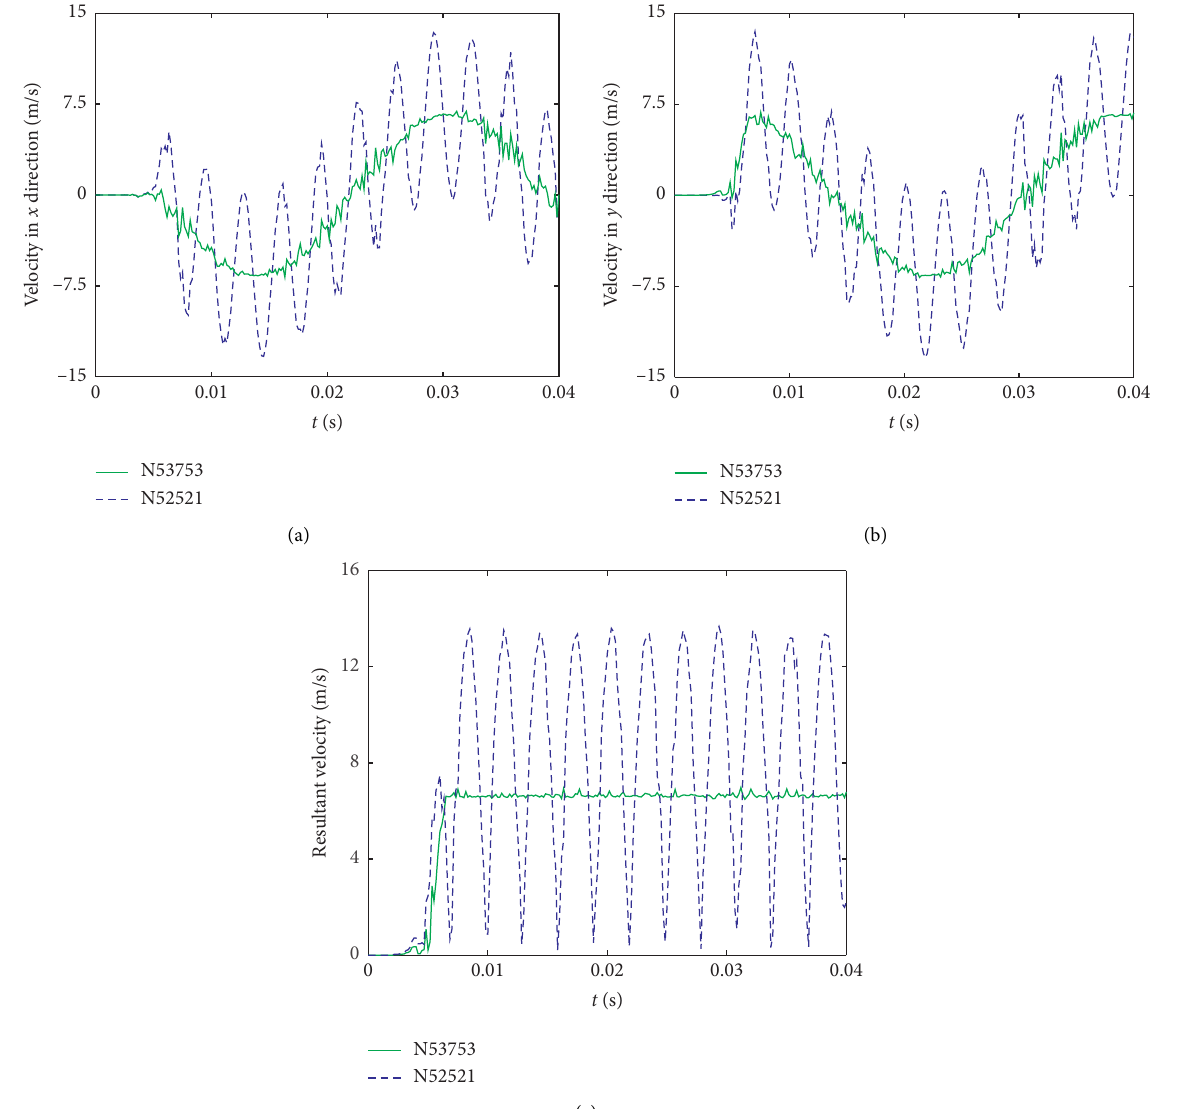
Figure 16: Rolling body center and surface node velocity curve. (a) Velocity in x direction. (b) Velocity in y direction. (c) Resultant